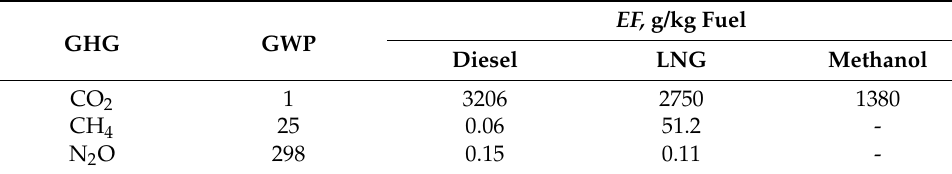
Table 1. Emissions factors for different power options.